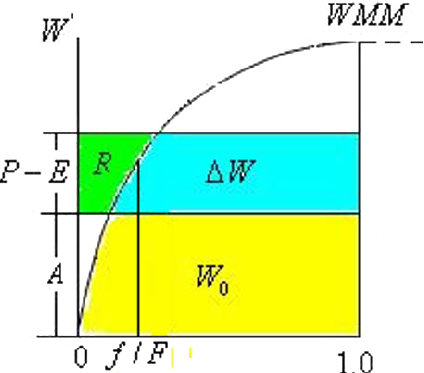
Figure 2. Tension water capacity curve of the XAJ model, which describes the tension water capacity distribution over the catchment. Each point on the curve represents a tension water capacity ( Y axis, ranging from 0 to WMM) and the proportion of the area that has a tension water capacity no larger than that value ( X axis). The mass balance calculation procedures of the XAJ model are presented: for a given time step when precipitation ( P ) is larger than evapotran- spiration (ET), the difference between P and ET is partitioned into runoff ( R , green shaded area) and soil water ( (cid:49)W , blue shaded area) based on the tension water capacity curve and initial soil water ( W 0 , yellow shaded